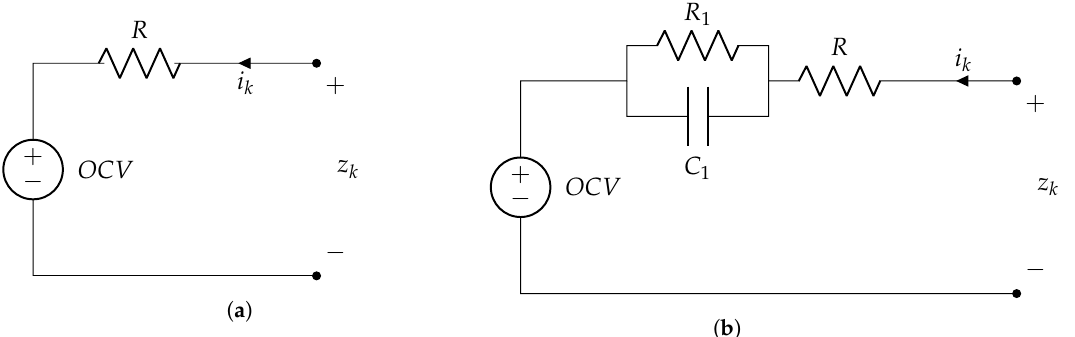
Figure 1. Equivalent circuit models used to describe battery cell dynamics. ( a ) Common Simple Model. ( b ) RC